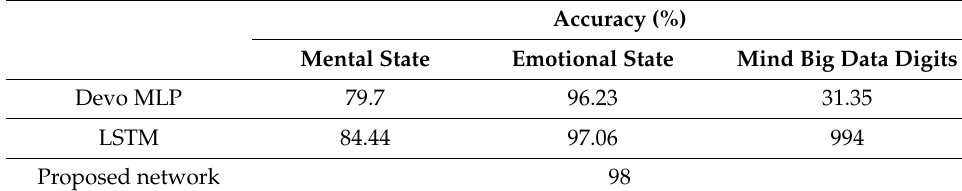
Table 6. Analysis of accuracy